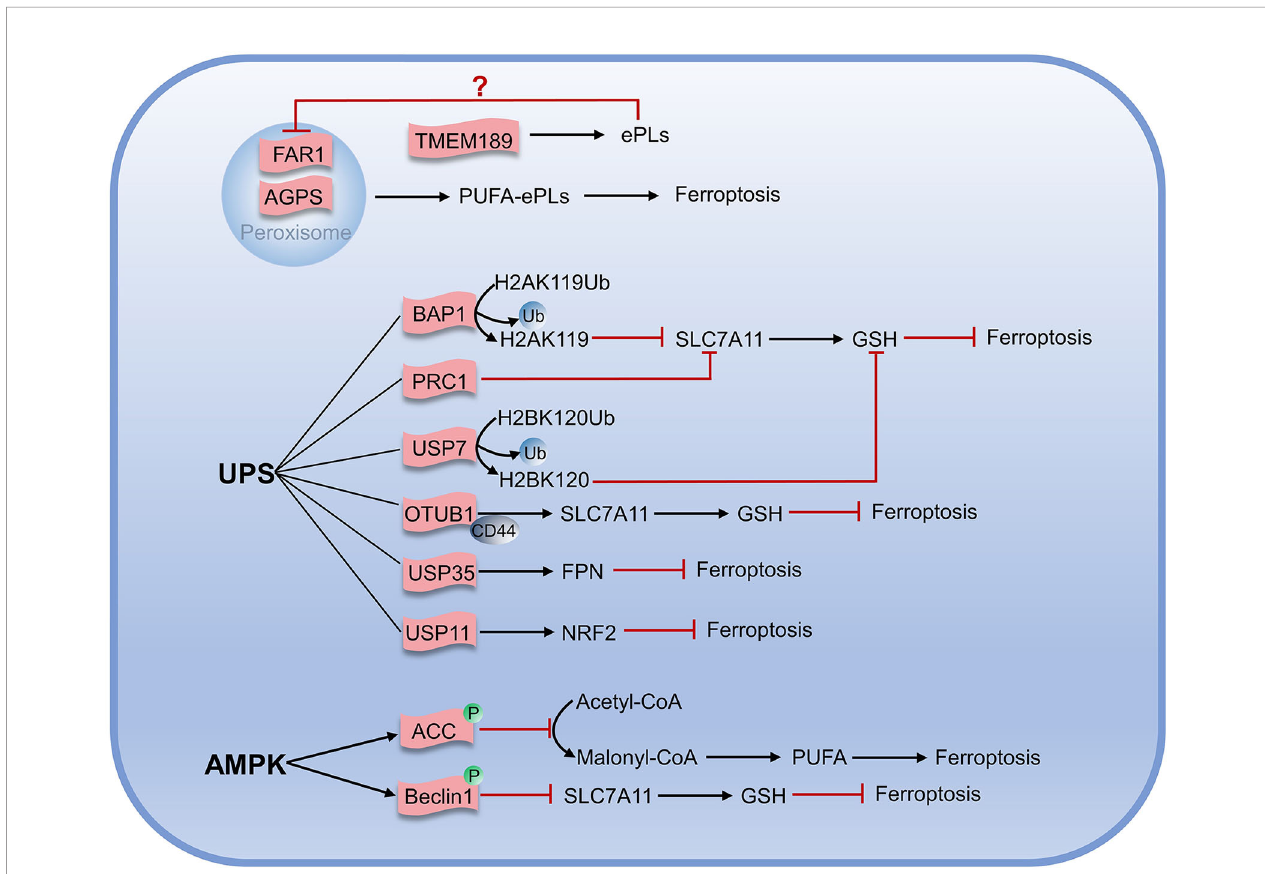
FIGURE 4 | Metabolic regulation associated with